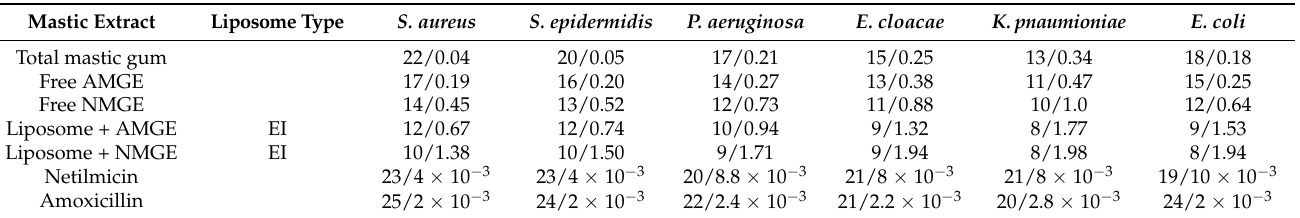
Table 2. Antibacterial activity (inhibition zone and MIC mg/mL, respectively) of mastic extracts before and after liposome encapsulation.